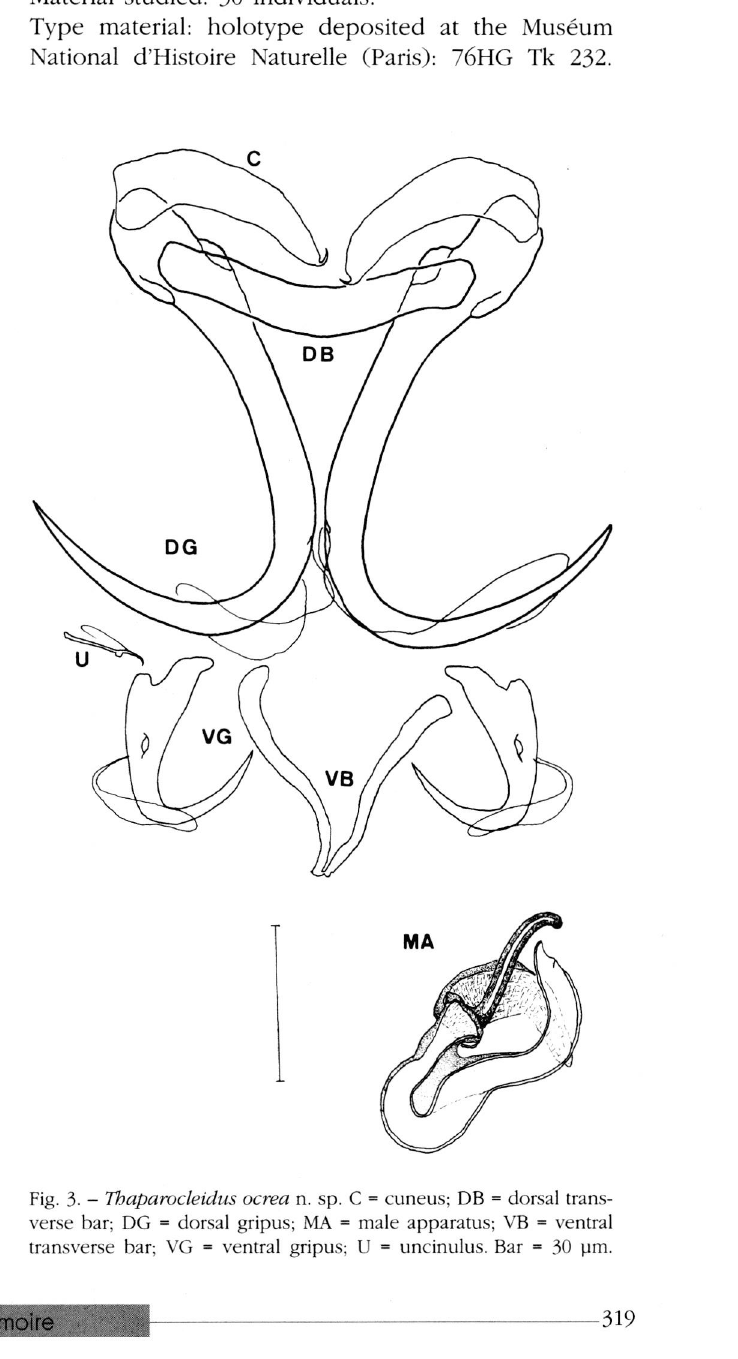
Fig. 3. - Thaparocleidus ocrea n. sp. C - cuneus; DB = dorsal trans verse bar; DG = dorsal gripus; MA = male apparatus; VB = ventral transverse bar; VG = ventral gripus; U = uncinulus. Bar = 30